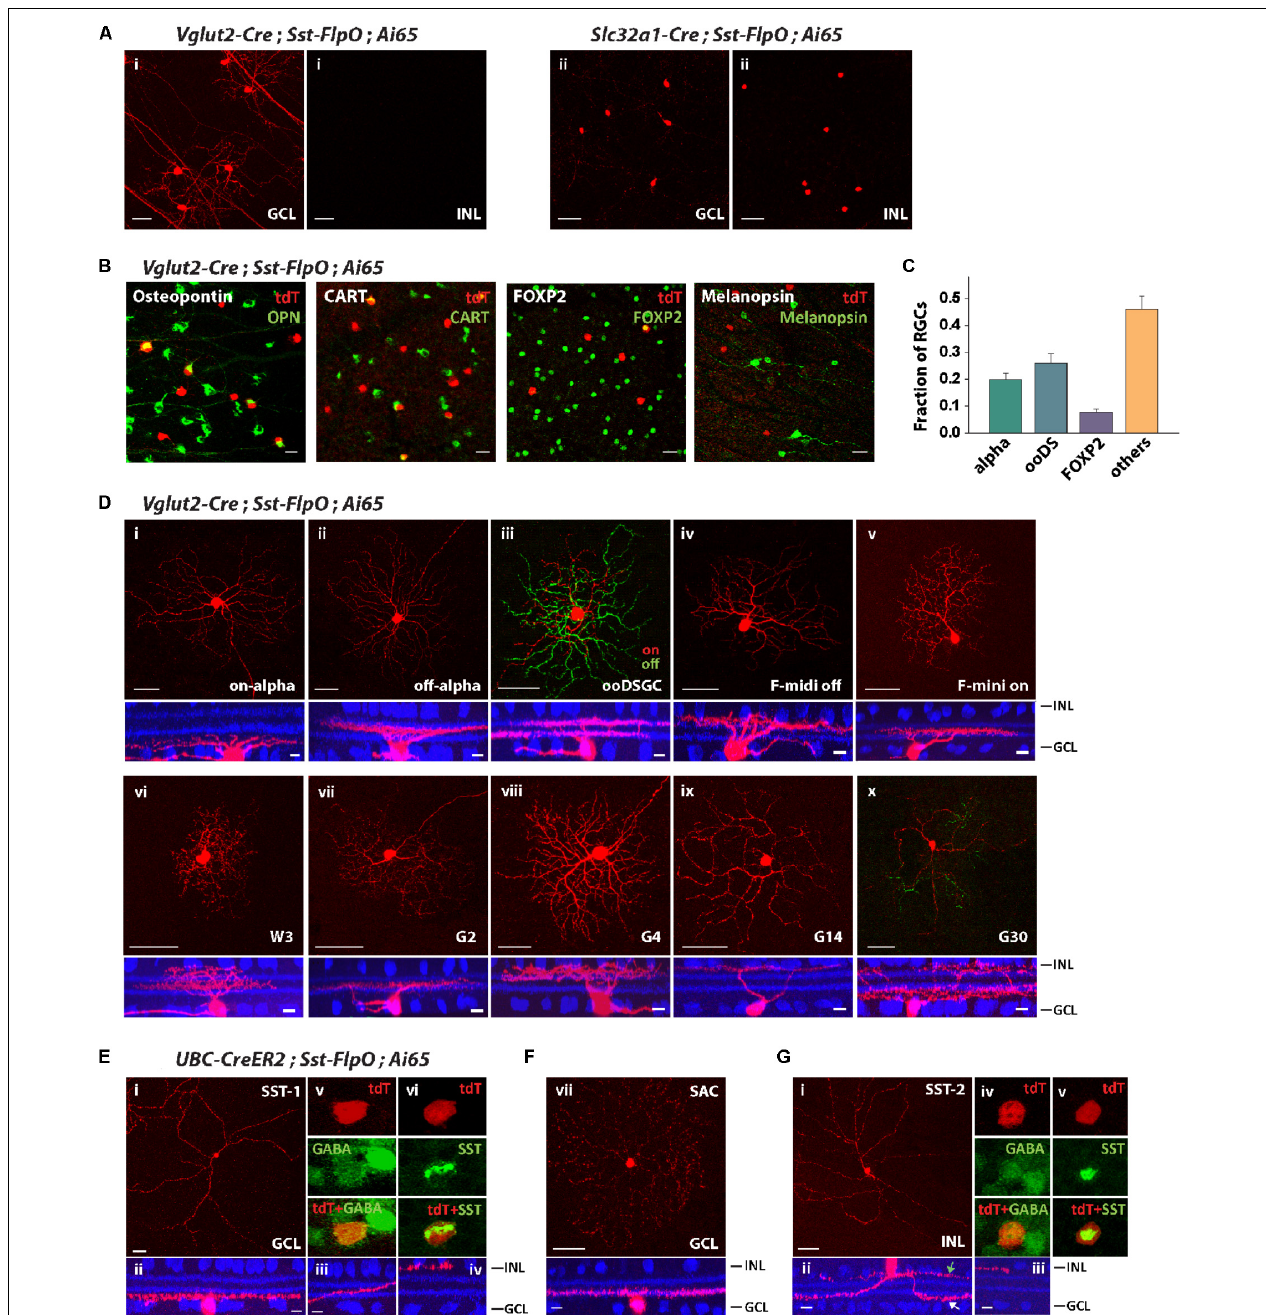
FIGURE 4 | The Sst-FlpO driver targeted both RGCs and ACs. (A) (i) To identify targeted RGCs, the Sst-FlpO driver was crossed with Vglut2-Cre and Ai65 reporter mice. (ii) To identify targeted amacrine cells, the Sst-FlpO driver was crossed with Slc32a1-Cre and Ai65 mice. Scale bar, 50 µ m. (B) Staining for RGC markers (green). RGC constituents were probed with antibodies against Osteopontin, CART, FOXP2 and melanopsin in the Vglut2-Cre ; Sst-FlpO;Ai65 retinas. Scale bar, 20 µ m. (C) Proportions of RGC types targeted in the Sst-FlpO driver. n = 7 retinas from 7 animals (6 litters). (D) Individual RGC types extracted from the Vglut2-Cre ; Sst-FlpO;Ai65 retinas. Flat-mount views (top) and side views (bottom) with ChAT (blue). Scale bar: 50 µ m for the flat-mount view, 10 µ m for the side view. (E–G) Amacrine cell types extracted from the UBC-CreER2;Sst-FlpO;Ai65 retinas, without tamoxifen administration. (E) Representative images of an SST-1 AC. (i) Flat-mount view of the soma and surrounding processes. (ii) Side view of the soma and surrounding “dendrite-like” and “axon-like” processes. (iii) Axon-like processes traveled across the IPL and ended at the INL border (iv) . An SST-1 AC was co-labeled with antibodies against GABA (v) and SST (vi) . (F) A starburst amacrine cell (SAC) in the GCL. Flat-mount view (top) and side view (bottom) with ChAT (blue). (G) SST-2 AC. Flat-mount view of the soma and surrounding processes. (ii) Side view of the soma and surrounding dendrite-like (white arrow) and axon-like processes (green arrow). (iii) Axon-like process end at the INL border. An SST-2 AC was co-labeled with antibodies against GABA (iv) and SST (v) . Scale bar for (E–G) : 50 µ m for the flat-mount view, 10 µ m for the side view.